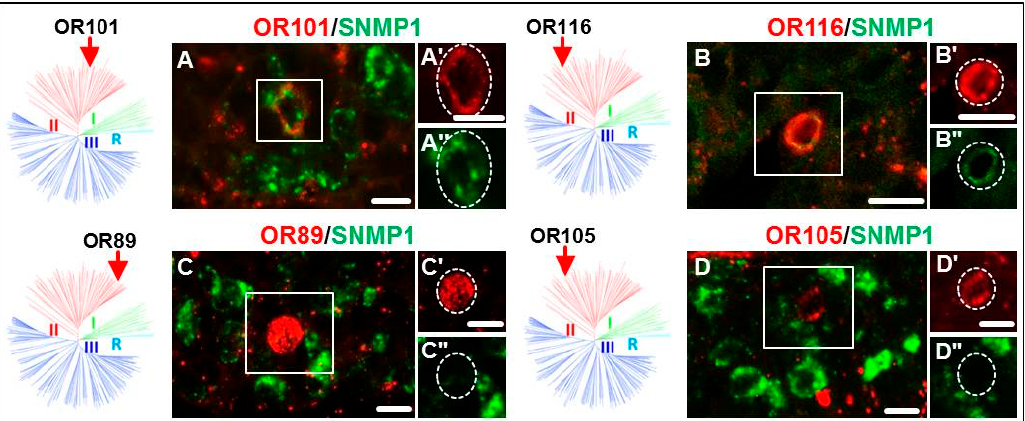
Figure 3. Expression of SNMP1 and group II SgreORs without an orthologous sequence. ( A–D ) Two-color FISH experiments on antennal sections from S. gregaria with specific antisense riboprobes for SNMP1 (green) and selected SgreORs of group II that lack an orthologue in L. migratoria (SgreOR101, SgreOR116, SgreOR89 and SgreOR105, red). ( A’–D’, A’’–D’’ ). High magnification images of the boxed areas in A–D are shown in either the red or the green fluorescence channel. Cells expressing the relevant SgreOR types are circumscribed by the dashed lines. In contrast to SgreOR89 and SgreOR105, SgreOR101 and SgreOR116 are co-expressed with SNMP1. Scale bars, 10 μ m. The position of the respective SgreOR types is denoted by arrows in the schematic representations of the phylogenetic tree depicted to the left of the images from FISH experiments.